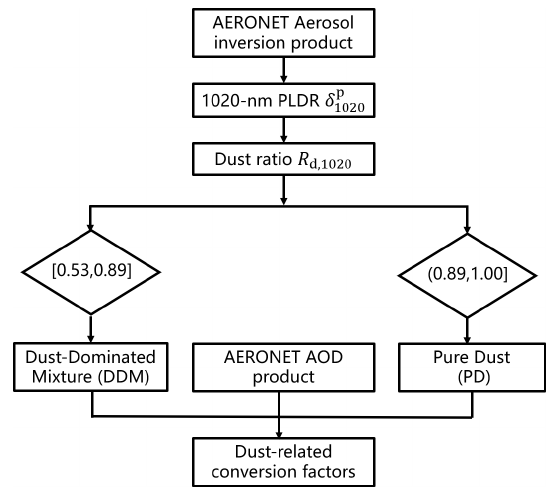
Figure 2. Flow chart for retrieving the dust-related POLIPHON conversion